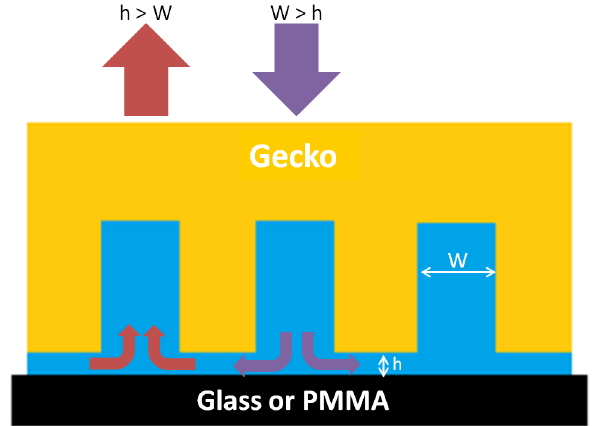
Figure 5. Schematic of the self-drying model. Schematic depicts a patterned gecko surface (pattern of four setae represented as yellow pillars) filled with water (blue) nearly contacting a substrate (glass or PMMA). Using the tree frog adhesive system as a model, we describe the inter-setal distance or microchannel width as W and the height of the intervening water layer as h. During a step, where the gecko setae approach the substrate, h R 0 and W . h (purple arrow), causing water to move out of the microchannels (small purple arrows). When the gecko removes the foot, using digital hyperextension, h increases and at h . W (red arrow), remaining water is moved back into the microchannels (small red arrows). The movement of water in and out of the microchannels is due to the pressure difference in the microchannels and thin water film.